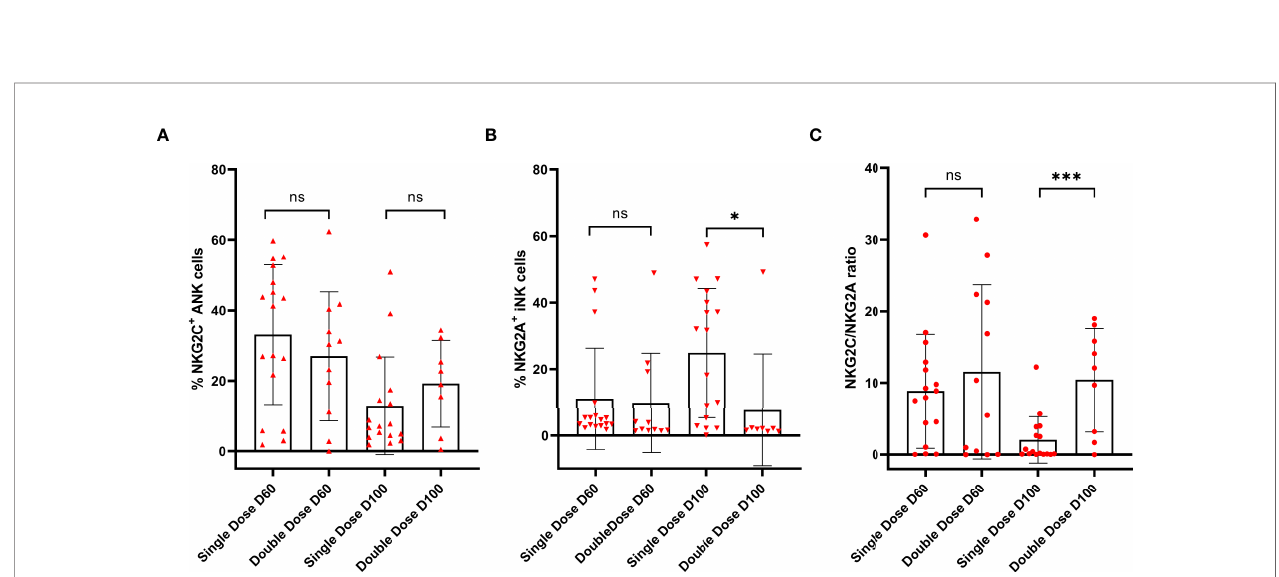
FIGURE 6 | Impact of the second dose of Mw on ANK and INK cells: Scatter dot with bar plot showing expression of (A) NKG2C + ANK (day 60, single dose; n=17, double dose; n=12 and day 100, single dose; n=17, double dose; n=12), (B) NKG2A + iNK cells (day 60, single dose; n=12, double dose; n=12 and day 100, single dose; n=17, double dose; n=12) and (C) NKG2C/NKG2A (day 60, single dose; n=17, double dose; n=12 and day 100, single dose; n=17, double dose; n=12) ratio with respect to single and double dose of Mw vaccine at day 60 and 100. Red upside and downside shaded triangles represent NKG2C + ANK and NKG2A + iNK, respectively, for Mw group. Red-shaded circle represents Mw group. ***p < 0.001, *p < 0.05 and ns, p value not signi fi